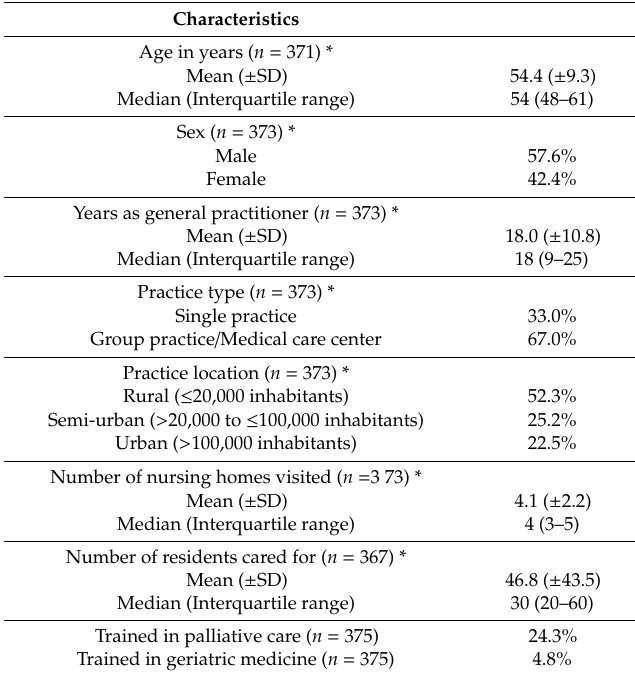
Table 1. Characteristics of the respondents ( n =